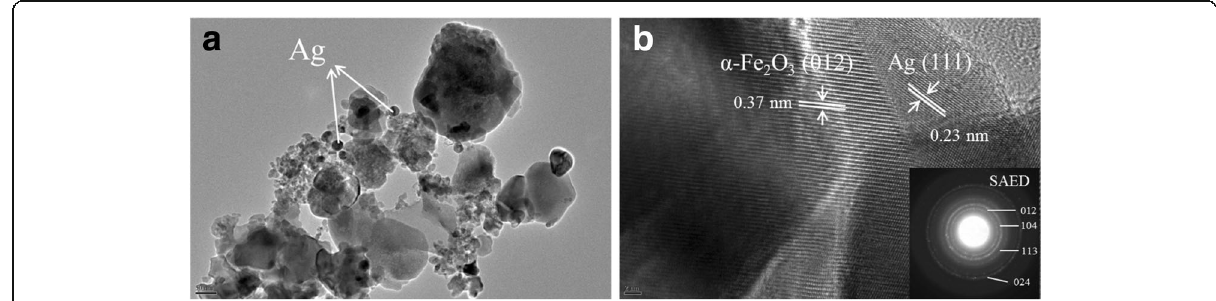
Fig. 5 TEM image of a 1%Ag/ α − Fe 2 O 3 and b the corresponding HR-TEM image with SAED pattern as an inset